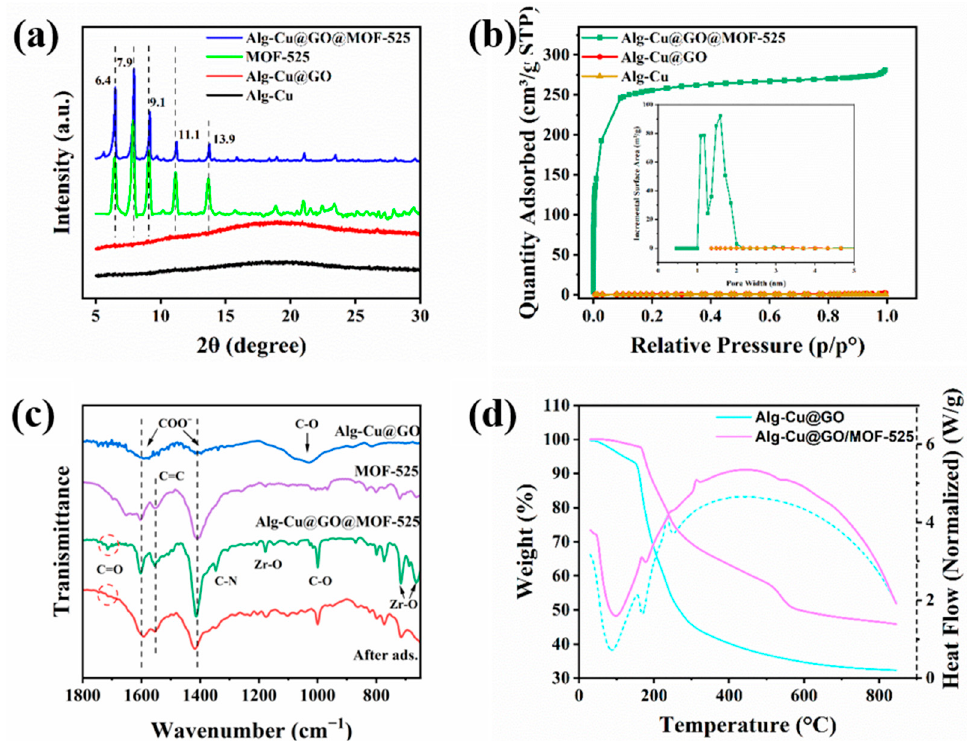
Figure 3. ( a ) XRD patterns, ( b ) N 2 adsorption–desorption isotherms, ( c ) FTIR spectra, and ( d ) TGA curves of the synthesized adsorbents.